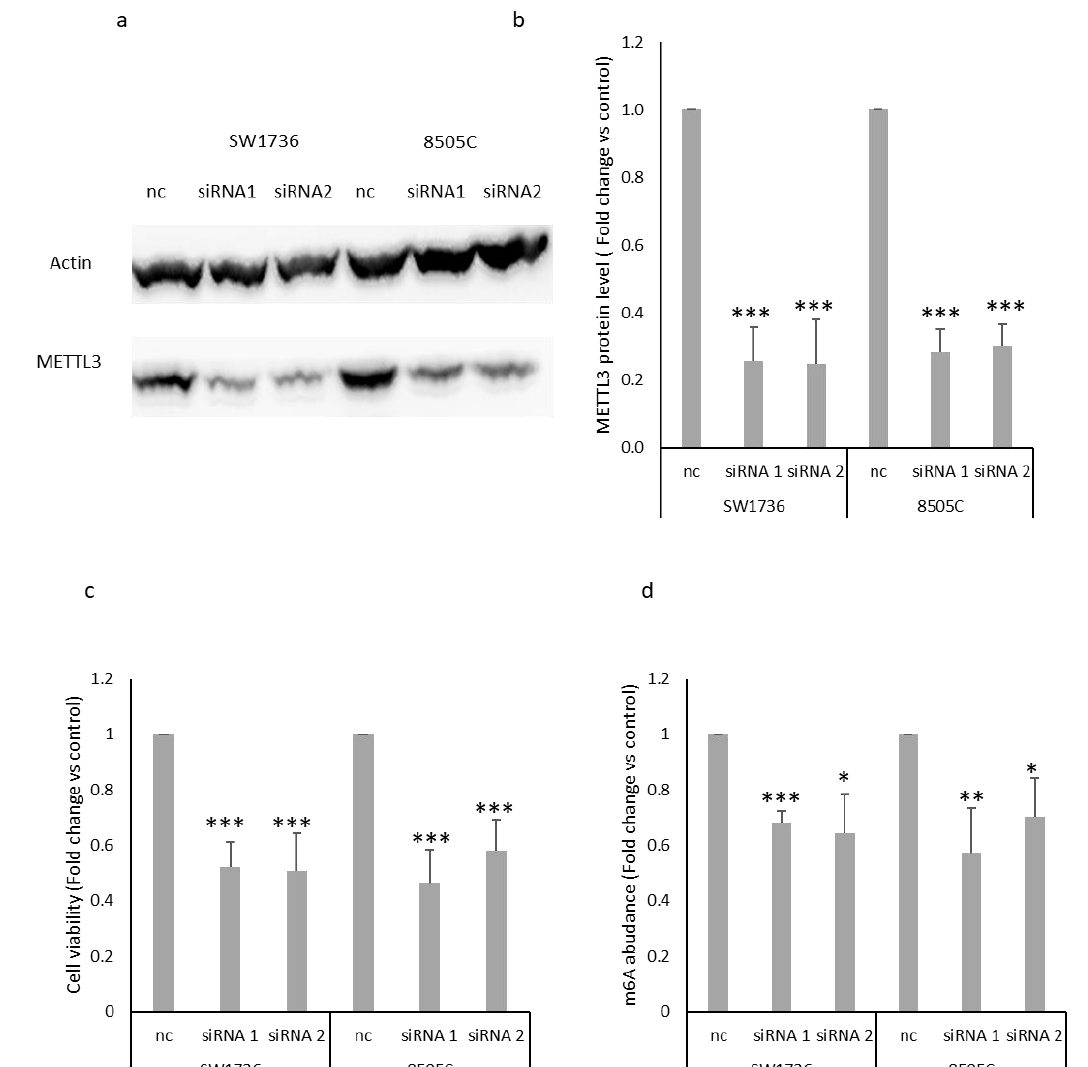
Figure 3. Effects of METTL3 silencing on cell viability and m6A total methylation in ATC cells. ( a ) Blot image of SW1736 and 8505C cells after 72 h transfection with non-targeting siRNA (nc, negative control) or two different siRNAs (siRNA 1 and siRNA 2) specific to METTL3 . ( b ) Densitometric analysis of METTL3 protein levels in ATC cells treated with negative control (nc) or two different siRNAs (siRNA 1 and siRNA 2) specific to METTL3. Data are normalized against β -actin levels. Nc was set to 1 and protein levels were expressed as fold change versus control. n = 3. *** p < 0.001. ( c ) Cell viability of SW1736 and 8505C cells, transfected with two siRNAs (siRNA 1 and siRNA 2) or negative control (nc) for 72 h, was analyzed by MTT assay. nc was set at 1 and cell viability was expressed as fold change versus control. n = 6. *** p < 0.001. ( d ) Colorimetric quantification of N6-methyladenosine in mRNA in ATC cells after METTL3 silencing (siRNA 1 and siRNA 2) or in negative control (nc). Nc was set to 1 and m6A RNA abundance was expressed as fold change versus control * p < 0.05, ** p < 0.01, *** p < 0.001.